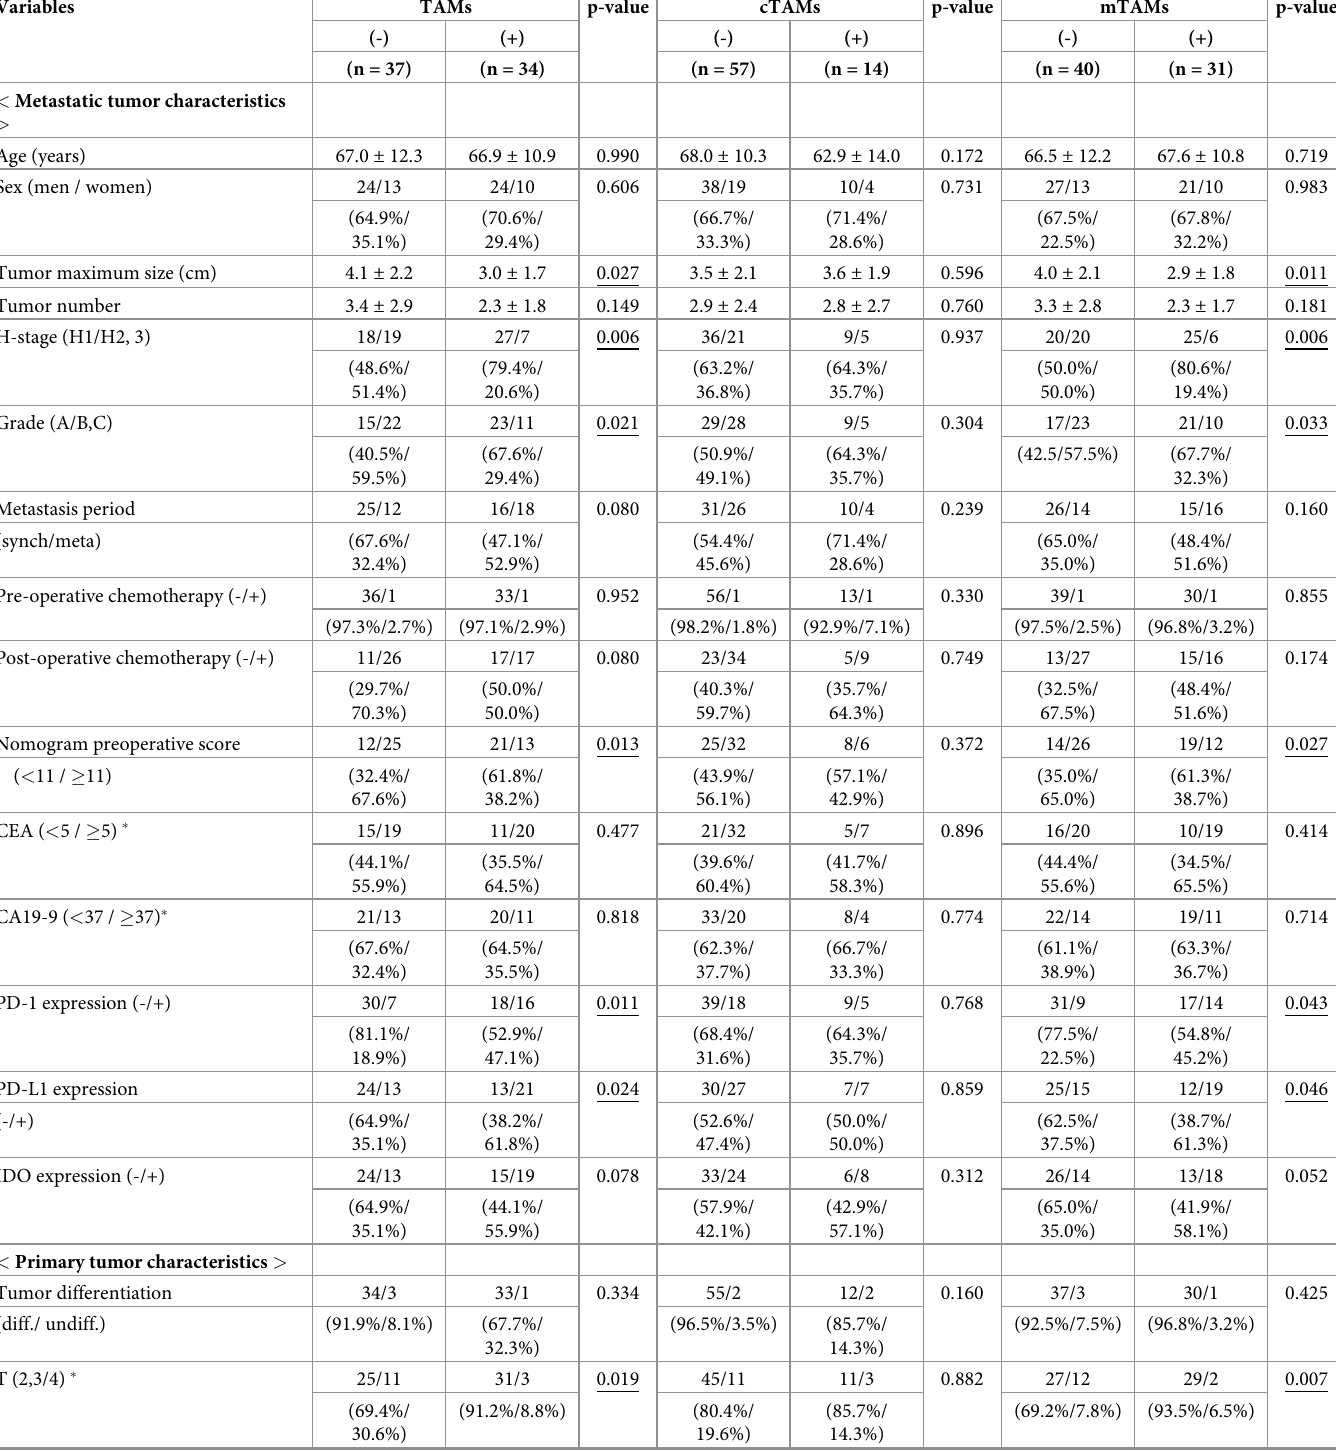
Table 4. Patients’ clinicopathological characteristics according to tumor-associated macrophage